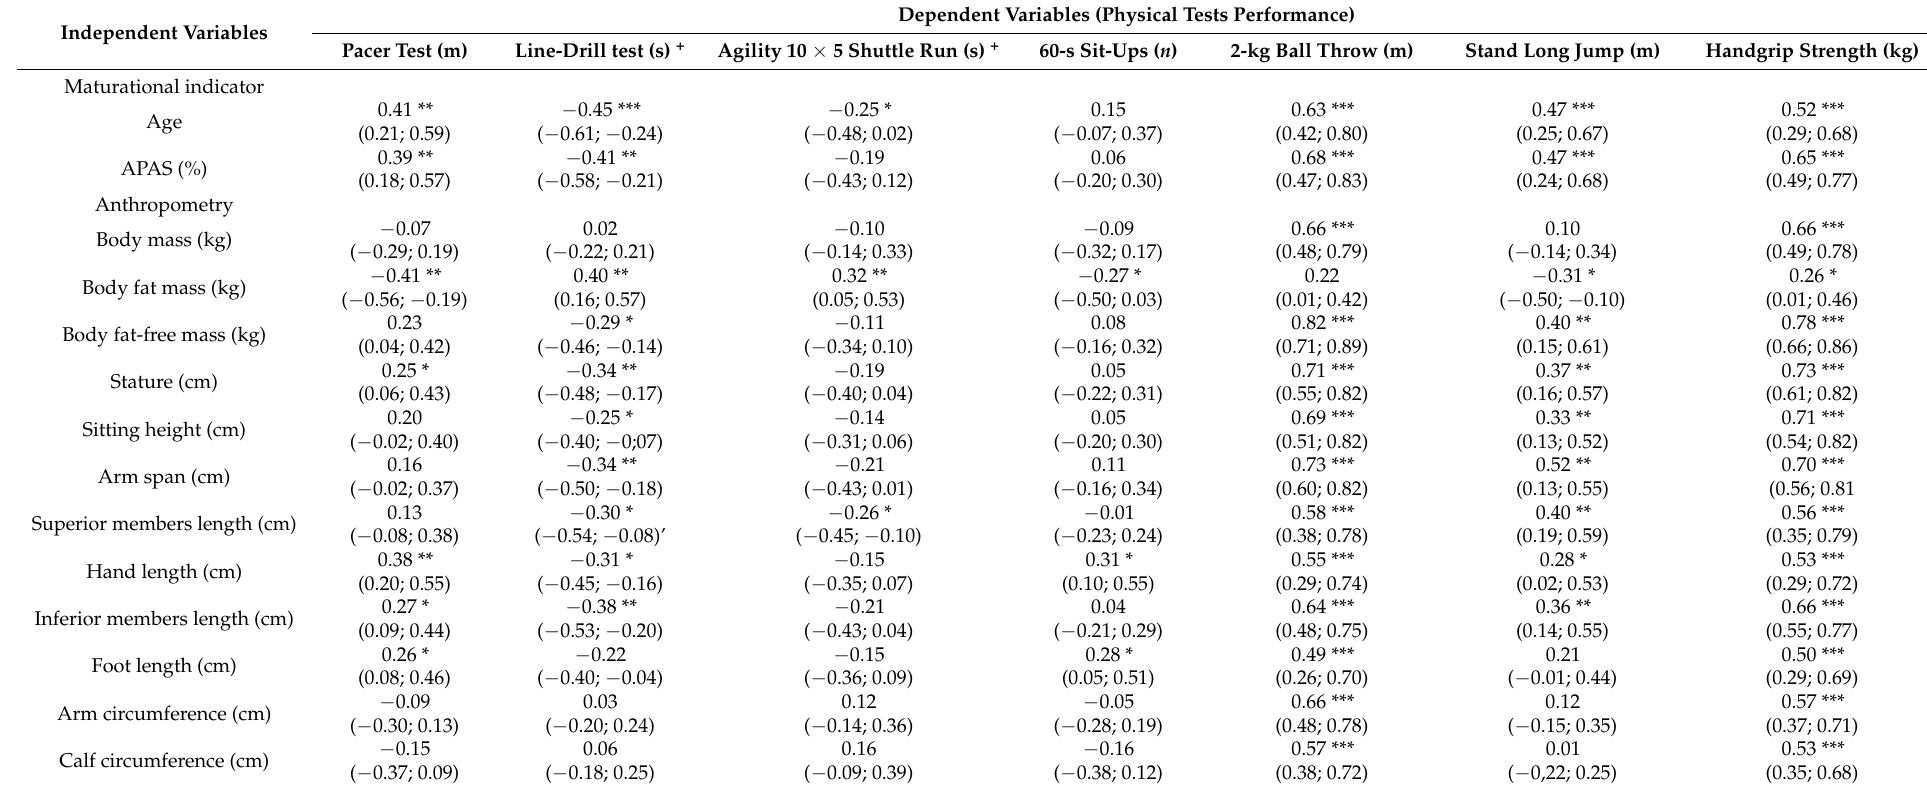
Table 2. Pearson bivariate correlation coefficients between maturational indicators and anthropometric variables, and physical tests performance variables, with 95% bias corrected and accelerated confidence limits based on 1000 bootstrap samples ( n =